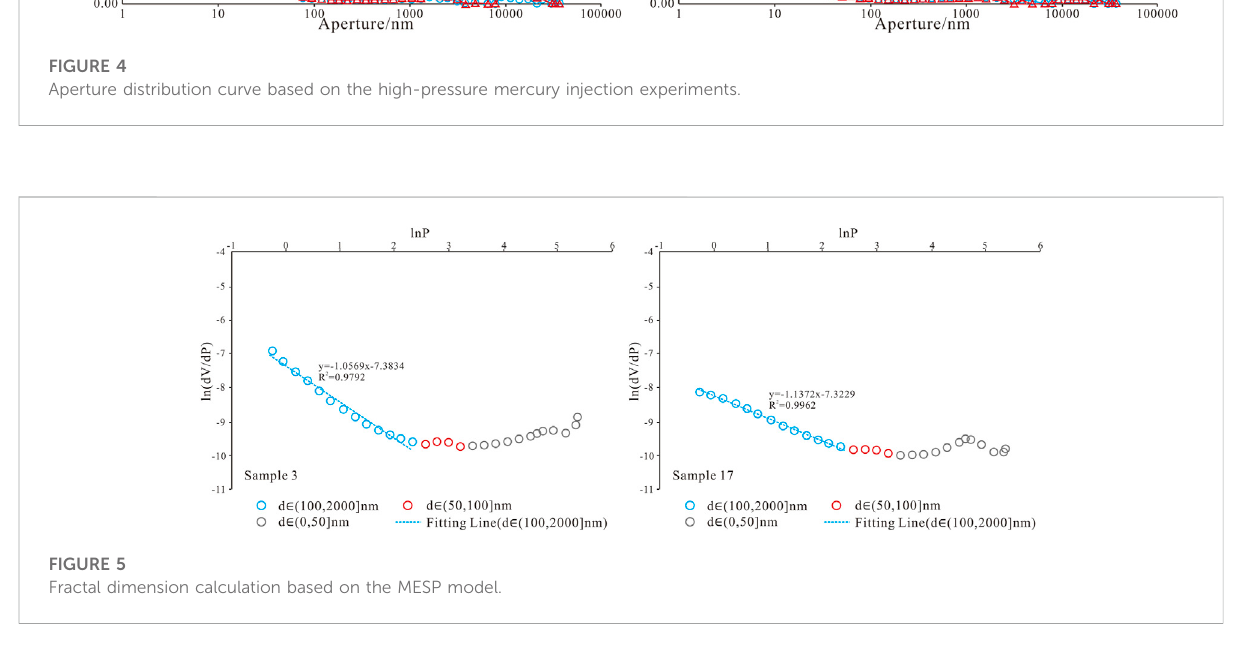
FIGURE 5 Fractal dimension calculation based on the MESP model.